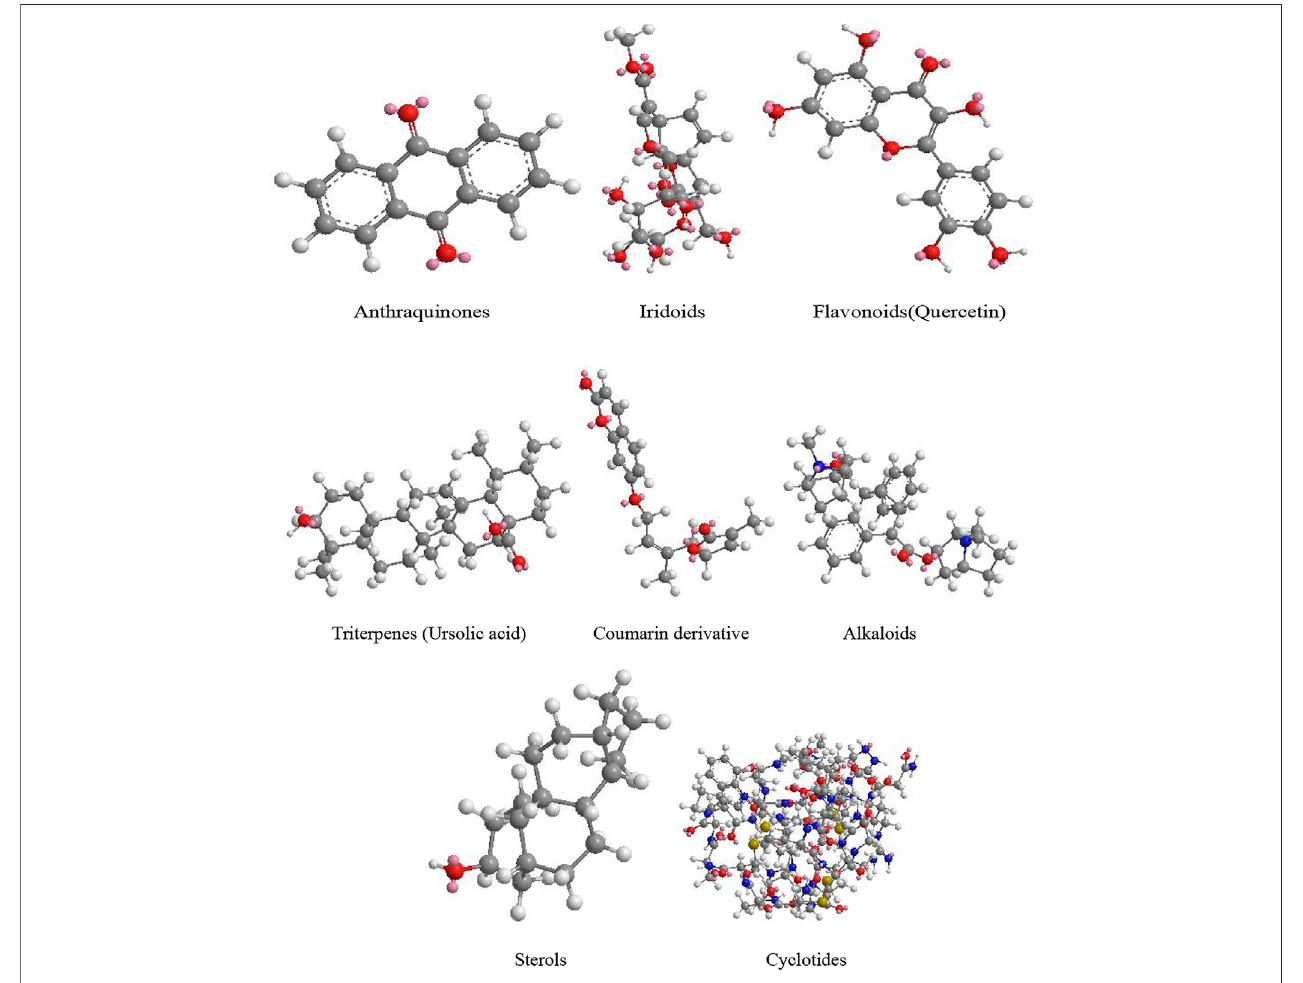
FIGURE 2 | Three-dimensional structures of representative antitumor